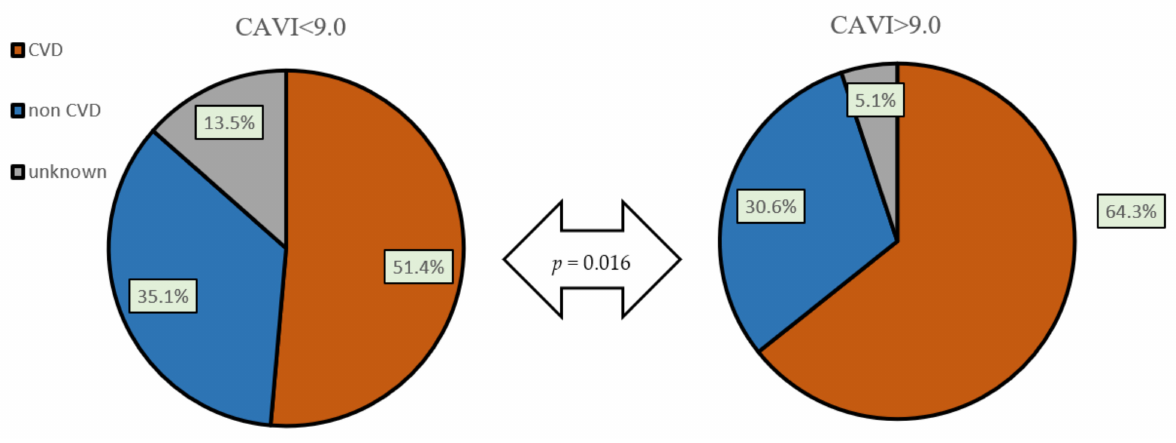
Figure 4. Structure of mortality in the long-term period. Notes: CVD—cardiovascular disease; CAVI—cardio-ankle vascular